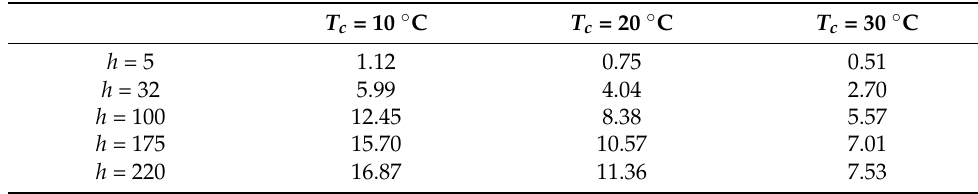
Table 8. Maximum current difference